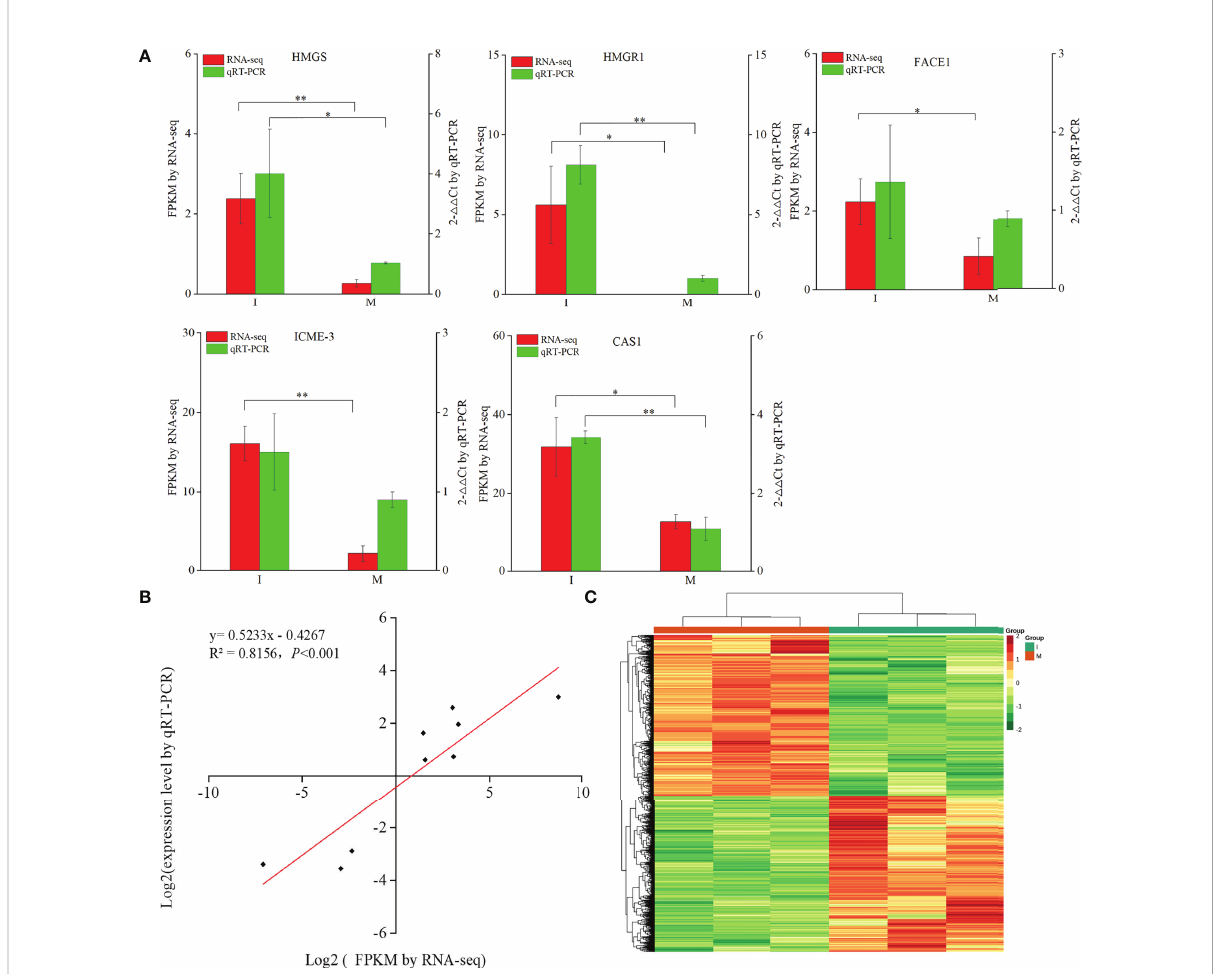
FIGURE 3 Analysis of DEGs replying to the intercropping system. (A) Comparison of the expression data of 5 key DEGs in steroidal alkaloids biosynthesis obtained by RNA-Seq and qRT-PCR. All data in the fi gure are indicated by mean ± SD (*, p <0.05; **, p <0.01). (B) Correlation of the results between RNA-Seq and qRT-PCR. The results were calculated by log 2 fold change. (C) Hierarchical clustering of all the